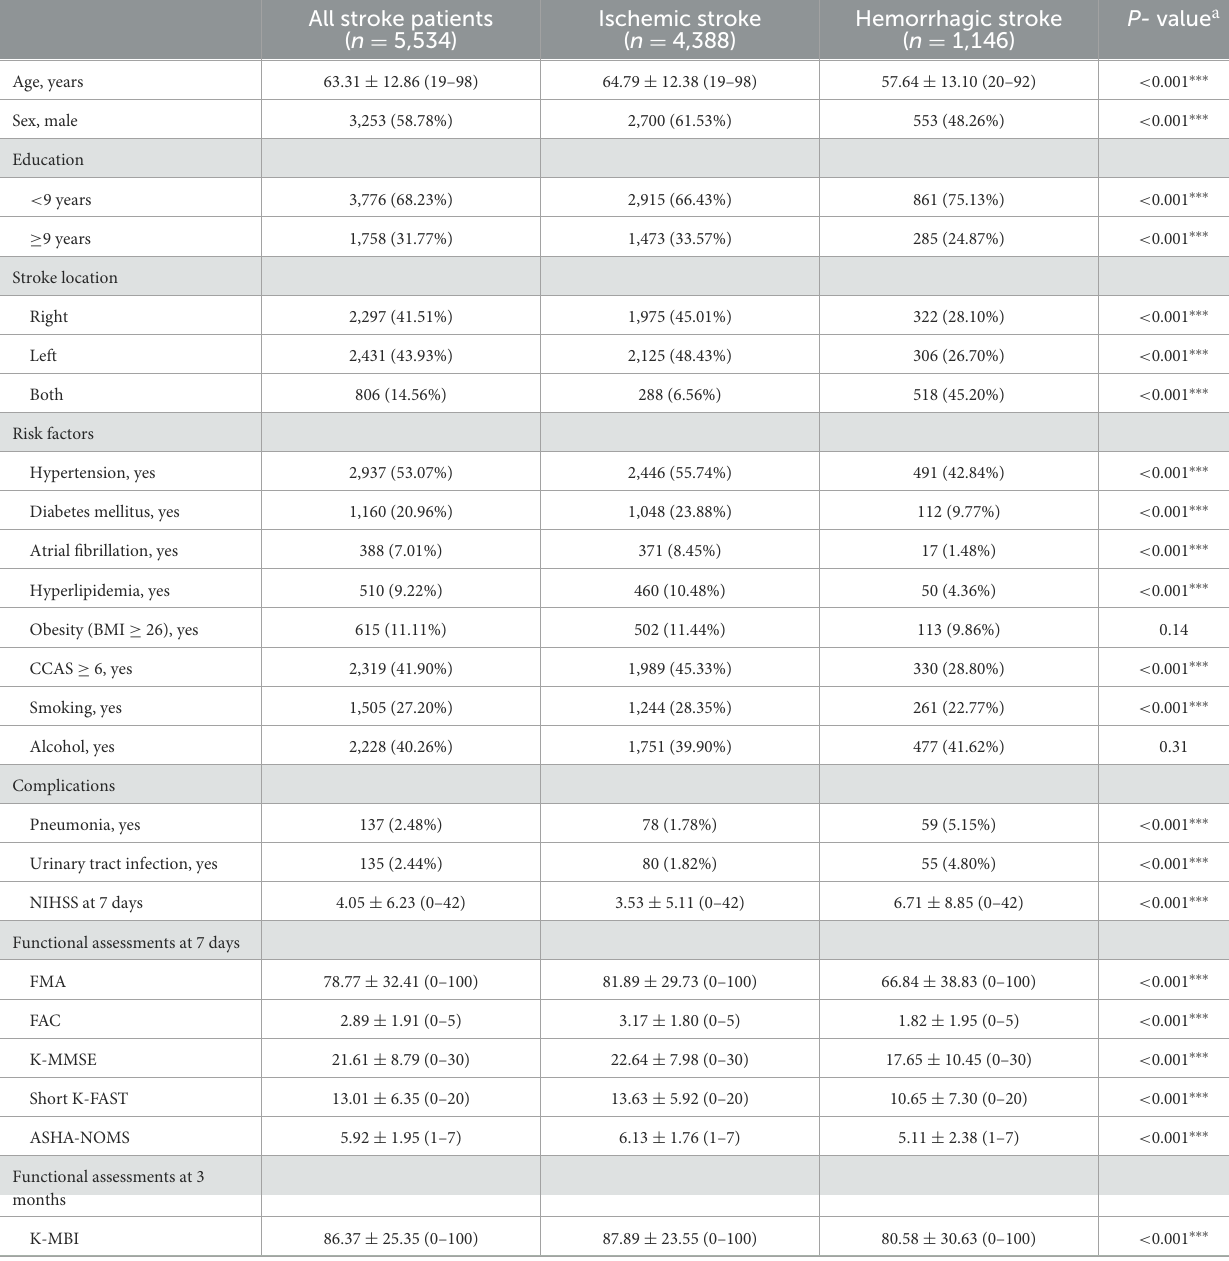
TABLE 1 Demographic and clinical characteristics of the participants.